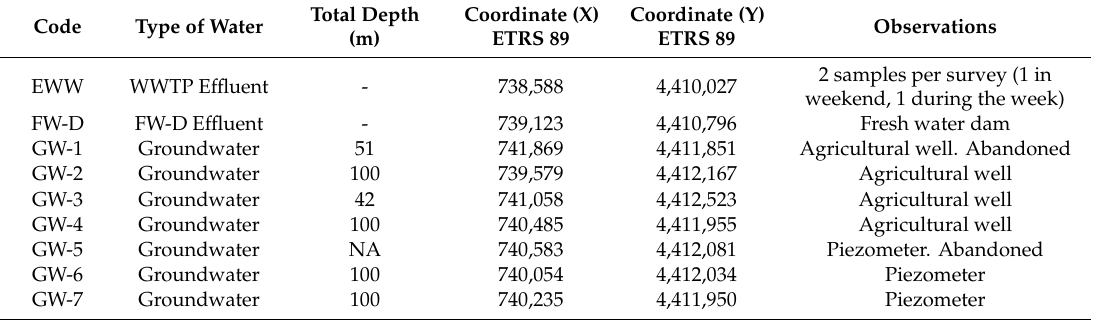
Table 1. Identification of the sampling